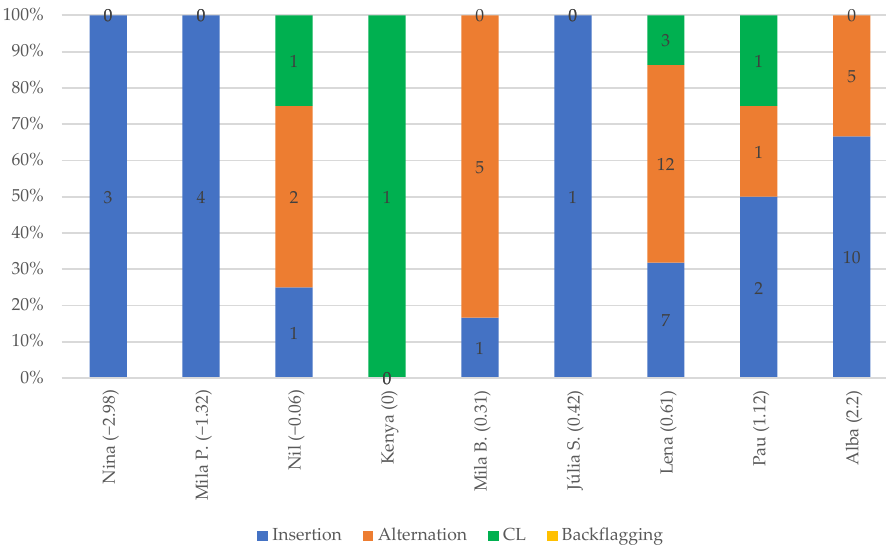
Figure 17. Four CS types according to language dominance.